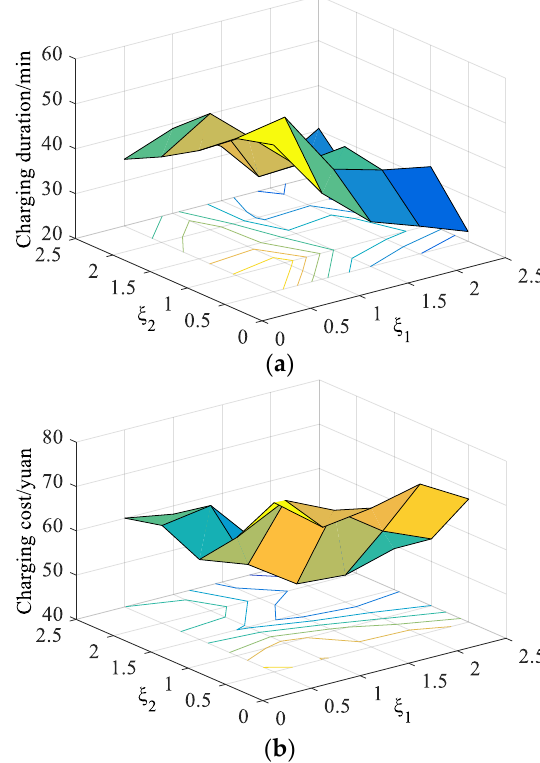
Figure 21. Charging duration and charging cost with different estimation parameters. ( a ) Charging duration with different estimation parameters. ( b ) Charging cost with different estimation parameters. Table 4. Evaluating indicators under different groups of estimation parameters.